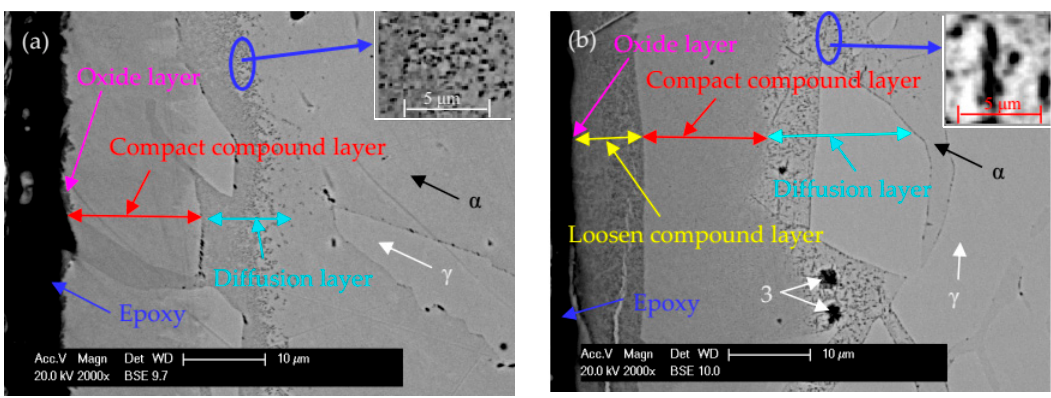
Figure 2. Cross-sectional SEM images of microstructure of the samples nitrided at two temperatures: ( a ) 570 °C; ( b ) 610 °C.